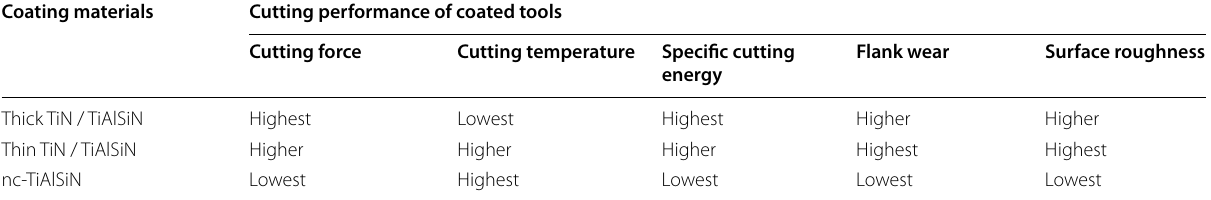
Table 5 Effect of coating materials on the cutting performances of coated tools Coating